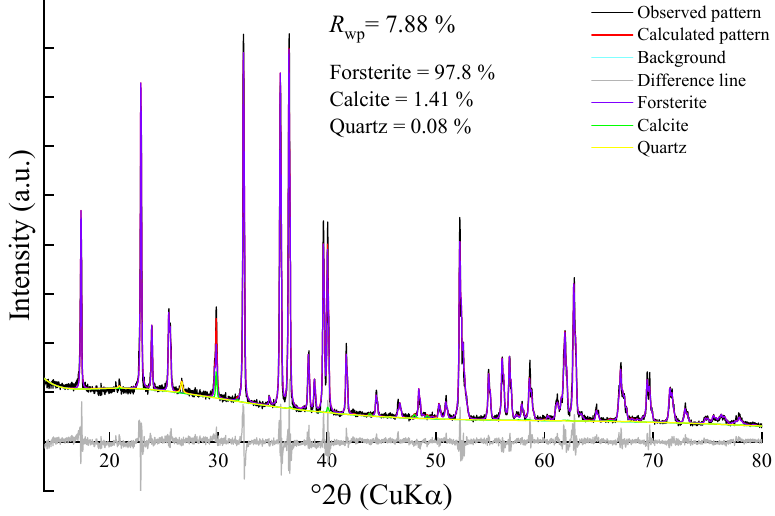
Table 1. Chemical composition of ferronickel slag (wt/%).